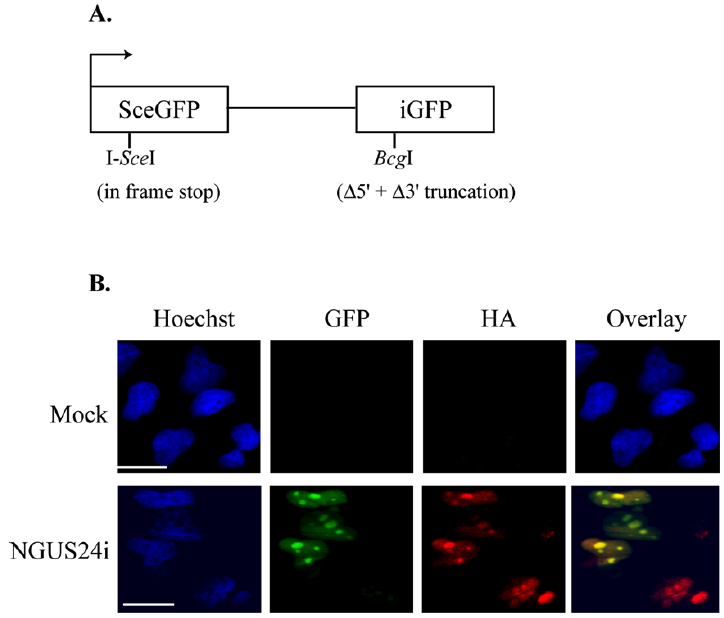
Figure 1. Efficient expression of I- Sce I from an Adenoviral vector based system in T98Gs with an integrated pDRGFP substrate. ( A ) Schematic diagram of reporter plasmid pDRGFP as described in [12]. ( B ) Representative IF staining of Ad-infected Clone 10. Cells were seeded onto glass coverslips and infected with Ad expressing I- Sce I (NGUS24i). Coverslips were harvested at 72 h post infection. GFP + cells were scored as HDR competent. Cells were stained with HA-specific Ab to detect HA-I- Sce I expressed from NGUS24i. Scale bar = 5 µm for all panels and all